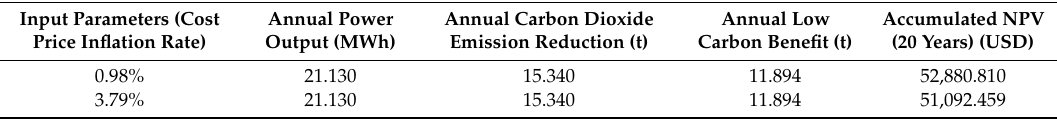
Table 17. The impact of cost price inflation rate on the environmental and economic profitability variables in this